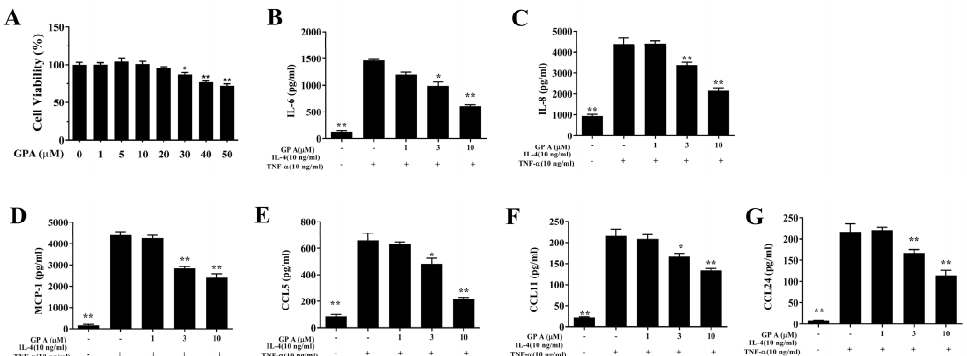
Figure 6. Effects of gypenoside A (GPA) on cytokine and chemokine production in BEAS-2B cells. ( A ) Cell viability with increasing concentrations of gypenoside A. ELISA showing ( B ) IL-6, ( C ) IL-8, ( D ) MCP-1, ( E ) CCL5, ( F ) CCL11, and ( G ) CCL24 levels in BEAS-2B cells. The data are presented as the mean ± SEM of three independent experiments (n = 12 per group). * p < 0.05, ** p < 0.01 compared to BEAS-2B cells stimulated with TNF- α